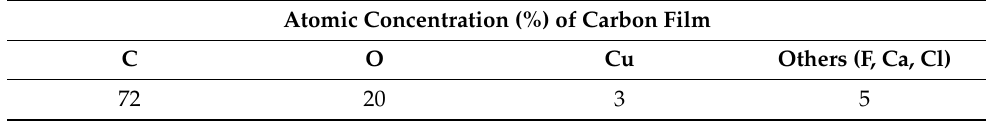
Table A1. Compositions of the carbon thin film measured by